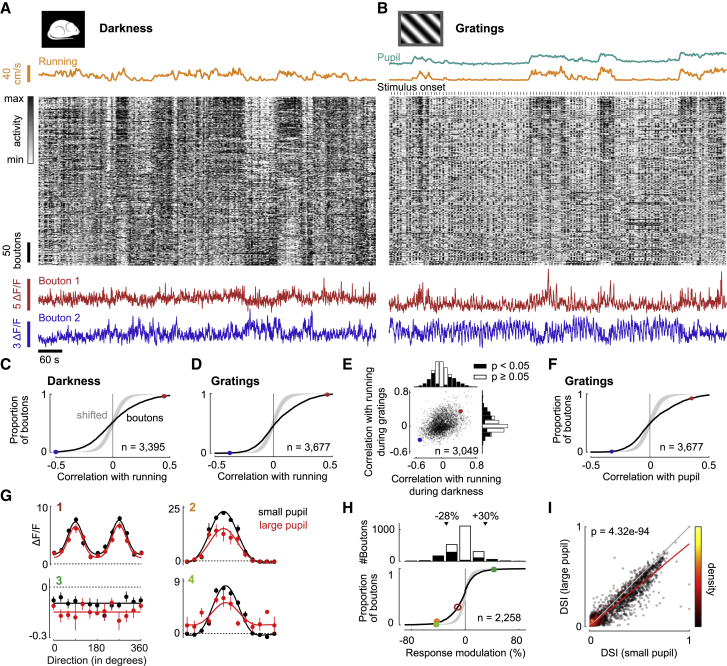
Activity in Retinal Boutons Varies with Arousal(A) Data from one experimental session recorded simultaneously during complete darkness showing running speed (yellow), calcium traces of retinal boutons (gray scale), and traces of two boutons (red and blue) that have positive and negative correlation with running. Calcium traces in gray scale were each Z scored and then sorted by mean correlation with running speed during darkness and during presentation of gratings (in B).(B) Data recorded from same retinal boutons as in (A) during presentation of gratings. In addition to (A), pupil size (green) and stimulus onsets (tick marks) are shown.(C) Correlation of retinal bouton calcium traces with running speed in darkness. Gray shade represents 2.5th to 97.5th percentile interval for null distribution generated by randomly shifting running trace against calcium traces. Dots show correlation strengths of example neurons in (A) and (B).(D) As in (C), but during presentation of gratings.(E) Correlation with running speed in darkness versus during visual stimulation for each bouton. Histograms show marginal distributions (same data as in C and D) for boutons with significant (black bars) and nonsignificant (white bars) correlations.(F) Correlation with pupil size during presentation of gratings.(G) Direction tuning (mean ± SEM) of four boutons during small (black) or large (red) pupil. Solid lines represent fitted tuning curves. Dotted lines represent 0 ΔF/F. Examples 1–3 are the same as in Figures 1H and 1I.(H) Distribution of arousal modulation for responses to gratings during small versus large pupil. Gray shade shows the 2.5th to 97.5th percentile interval of null distribution. Dots show modulations of examples in G (filled dots have significant modulations). Triangles (top) show mean values for boutons with significant positive or negative response modulations.(I) Direction selectivity index (DSI) during small versus large pupil for each bouton. Red line represents linear regression (linear mixed-effects model without intercept). Color of dots represents density in scatterplot.